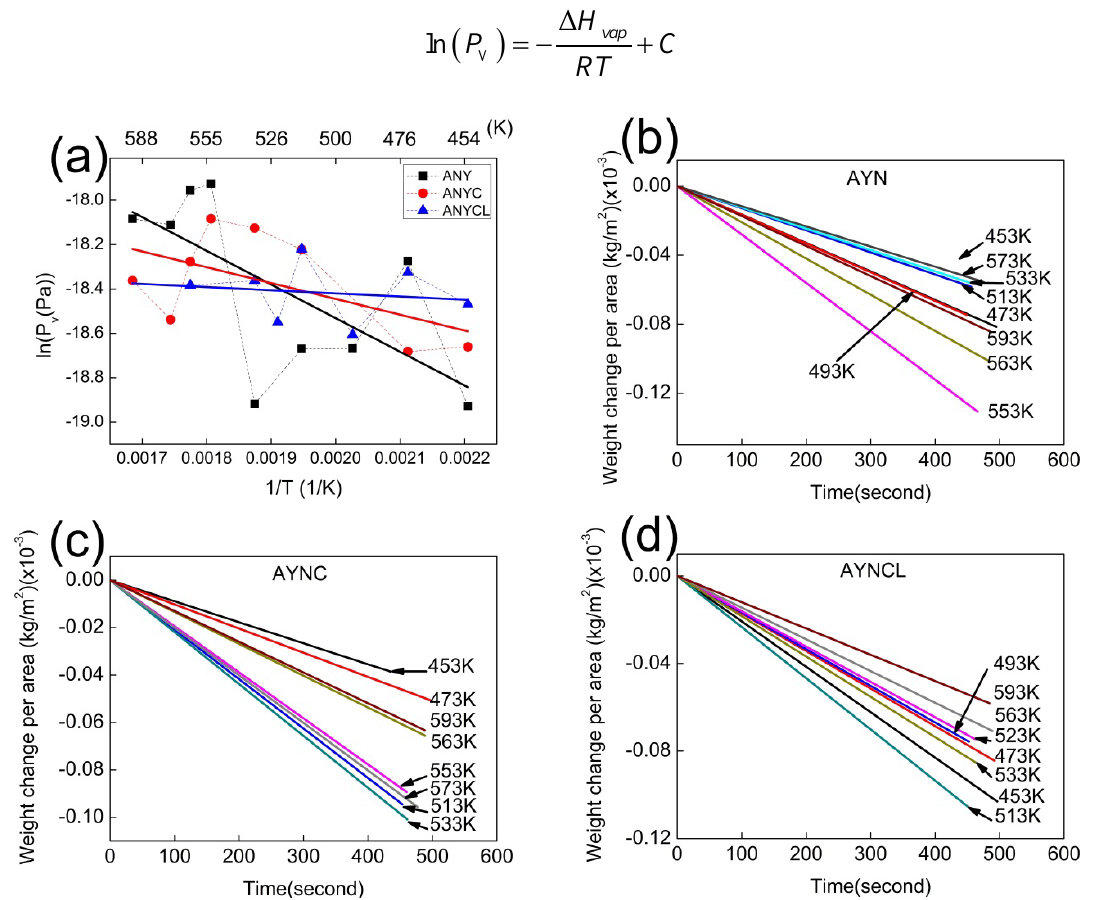
Figure 4. ( a ) Vapor pressures of AYN, AYNC, and AYNCL as a function of temperature: The data points fit a straight line for each composite and were used to calculate the enthalpy of vaporization; and ( b – d ) the individual data points of the three composites in ( a ) were obtained by measuring weight losses per unit area as a function of time at various temperatures in